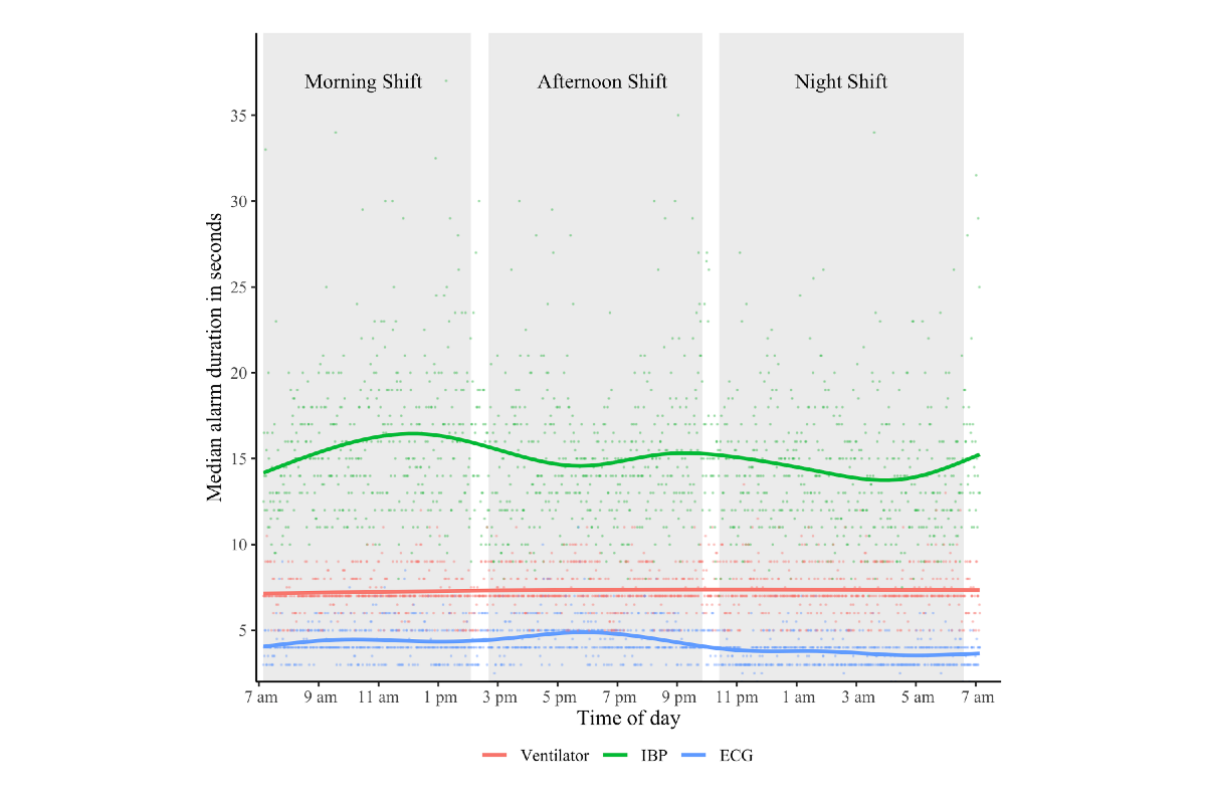
Figure 6. Median alarm duration of the 3 medical devices that issue most alarms over 24 hours. Each dot represents the median alarm duration for each minute of the day of the respective device. The line for each device is based on ggplot2’s smoothing function and represents a generalized additive model of the distribution (with the formula y ~ s(x, bs = "cs"). The white spaces between the grey bars (ie, shifts) visualize handover periods. ECG: electrocardiogram; IBP: invasive blood pressure.